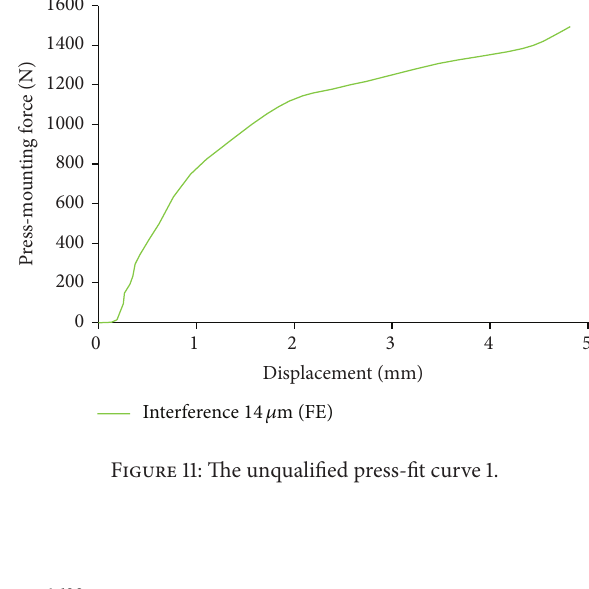
Figure 11: The unqualified press-fit curve 1.